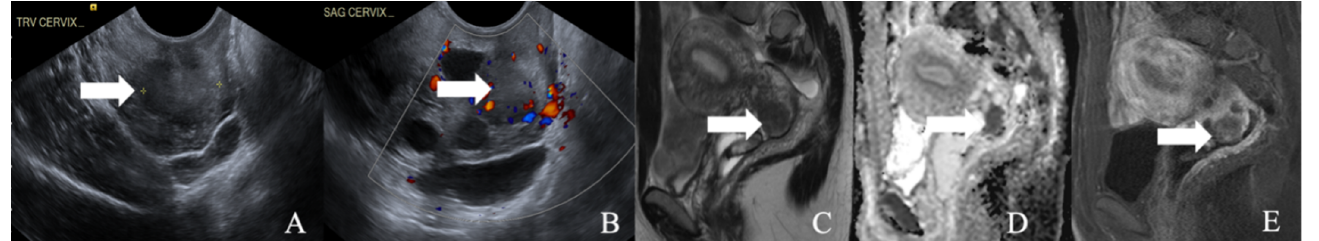
Figure 4. A 52-year-old female with a neuroendocrine tumor of the cervix uteri. ( A ) Transverse and ( B ) sagittal ultrasound image of the cervix demonstrates a heterogenous cervical mass (arrow) measuring about 14 cm. ( C ) Sagittal T2 weighted image, ( D ) sagittal apparent diffusion coefficient map, and ( E ) sagittal fat-saturated post-contrast T1 weighted MRI images demonstrate a mass in the cervix uteri (arrow) with restricted diffusion. The mass biopsy reported a small cell neuroendocrine tumor of grade G3.